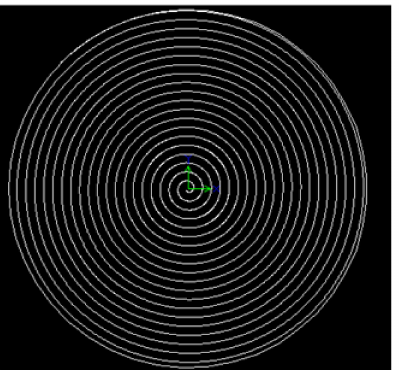
Figure 1. Computer-aided design image of the channel written with CO 2 laser system.